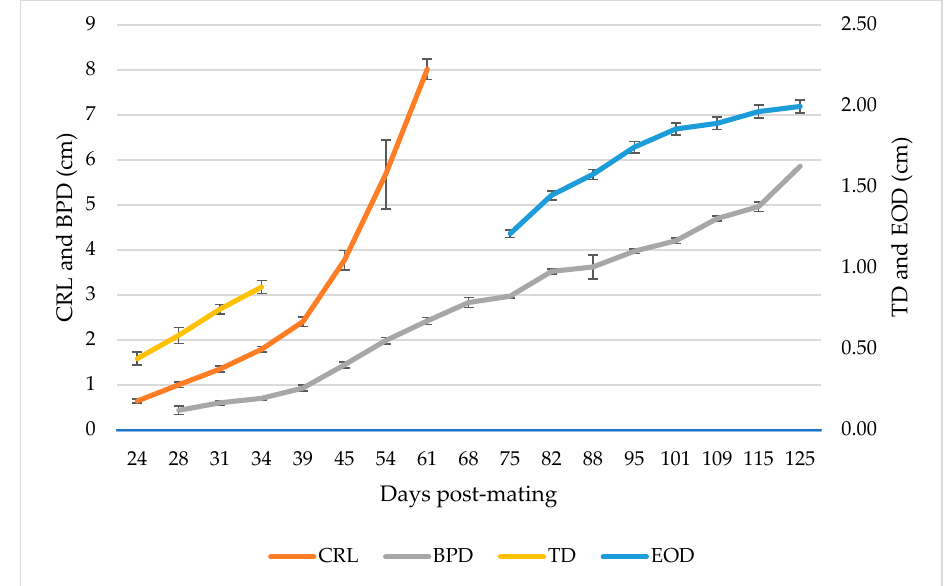
Figure 3. Evolution curves of crown-rump length (CRL) and biparietal diameter (BPD) (left y -axis), trunk diameter (TD) and eye orbit diameter (EOD) (right y -axis) in total goats under study ( n : 9). The mean and the standard deviation of the measurements are plotted in relation to the days after mating.